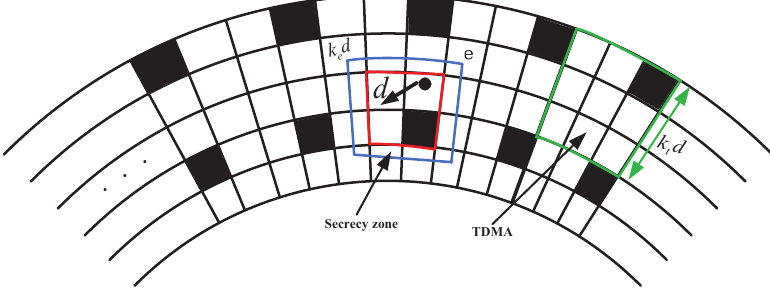
Figure 4. An illustration of the TDMA strategy with size k t d . The blue square surrounding the transmitter is the secrecy zone, which is at most k e d squares away from the